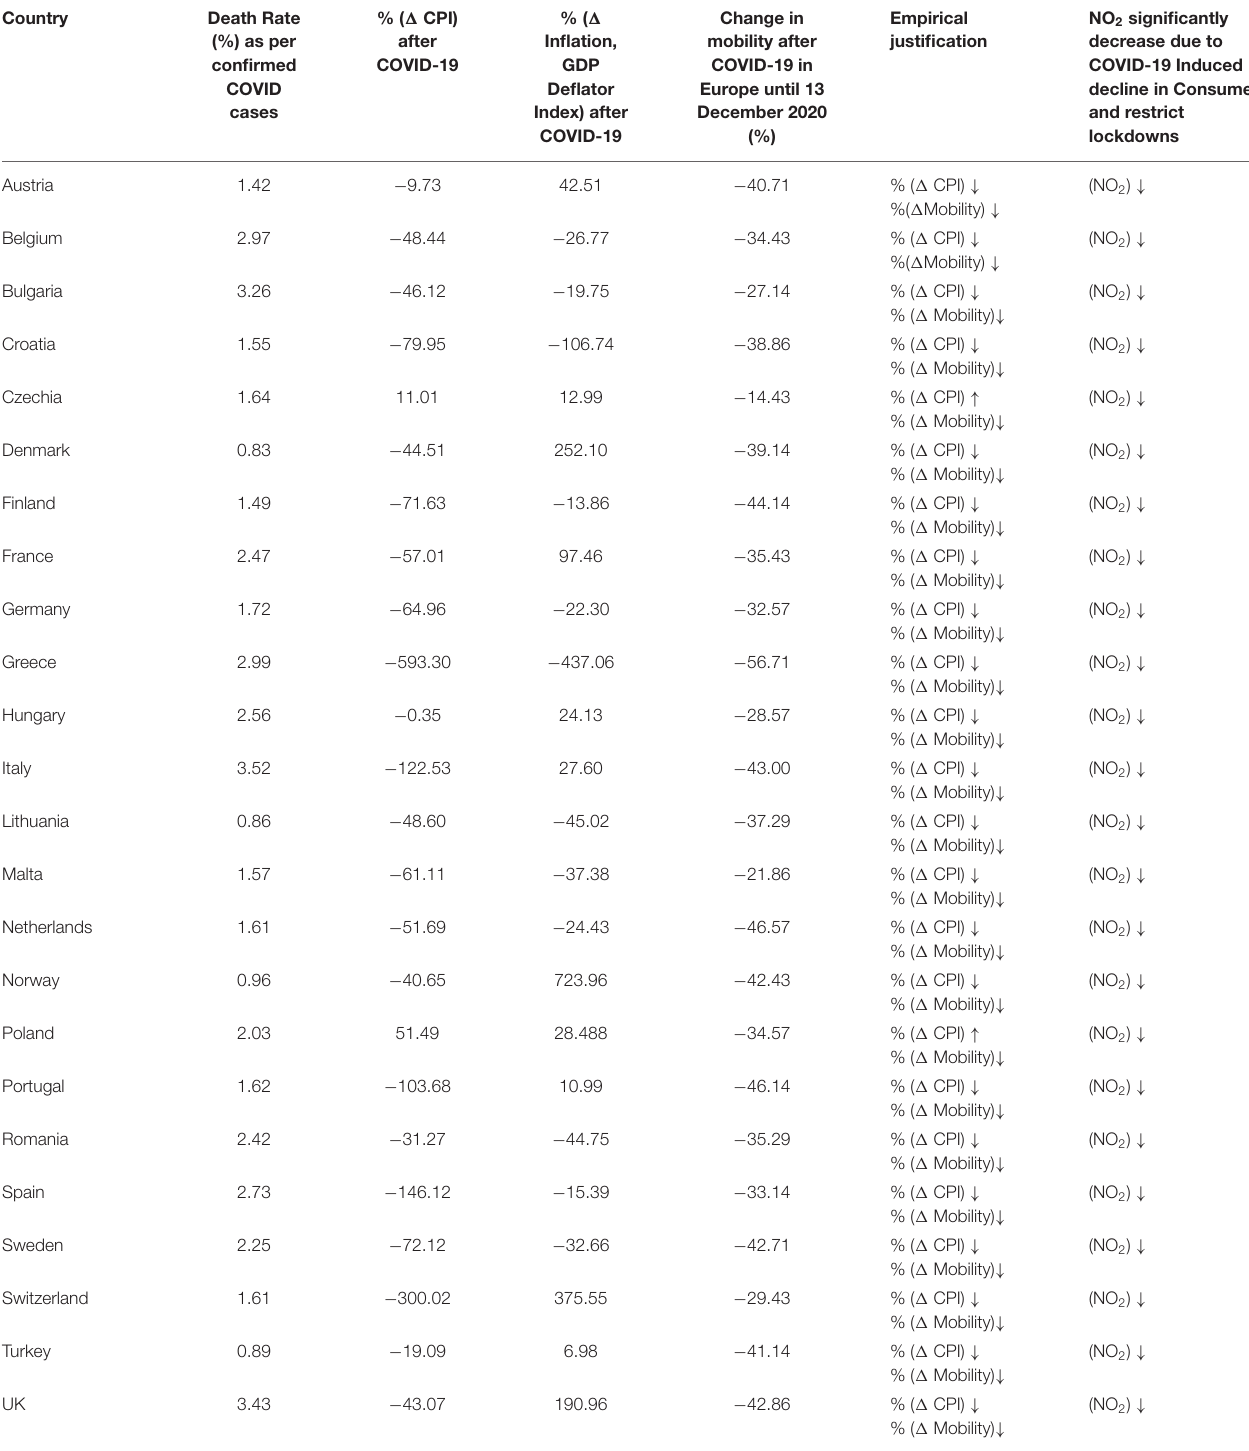
TABLE 7 | Analyzing the empirical impact of COVID-19-induced decline in consumer goods and mobility on nitrogen dioxide (NO 2 ) emission in Europe through data estimation.